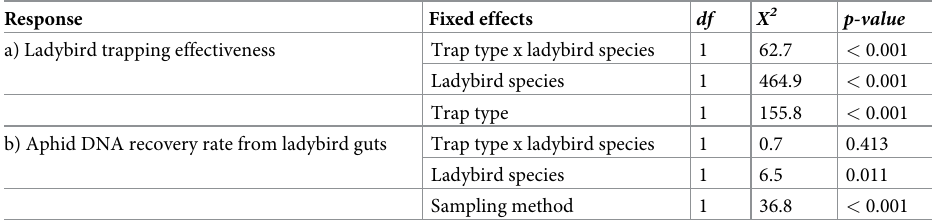
Table 2. Statistical evaluation of trapping success and DNA recovery